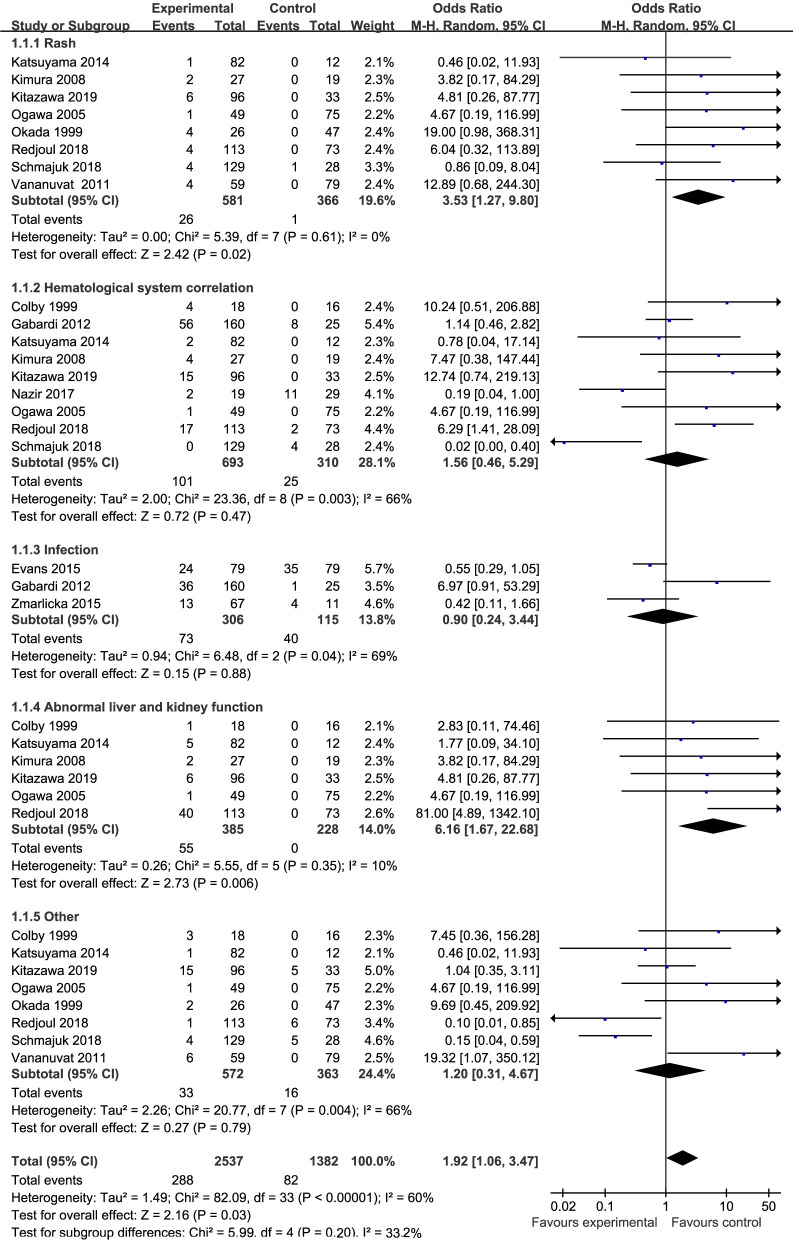
Forest plot of the rate of AEs.The vertical line indicates no difference between the groups. ORs are represented by diamonds, and 95% CIs are depicted by horizontal lines. Squares indicate point estimates, and the size of each square indicates the weight of the given study in the meta-analysis. M-H, Mantel-Haenszel random- effects model.